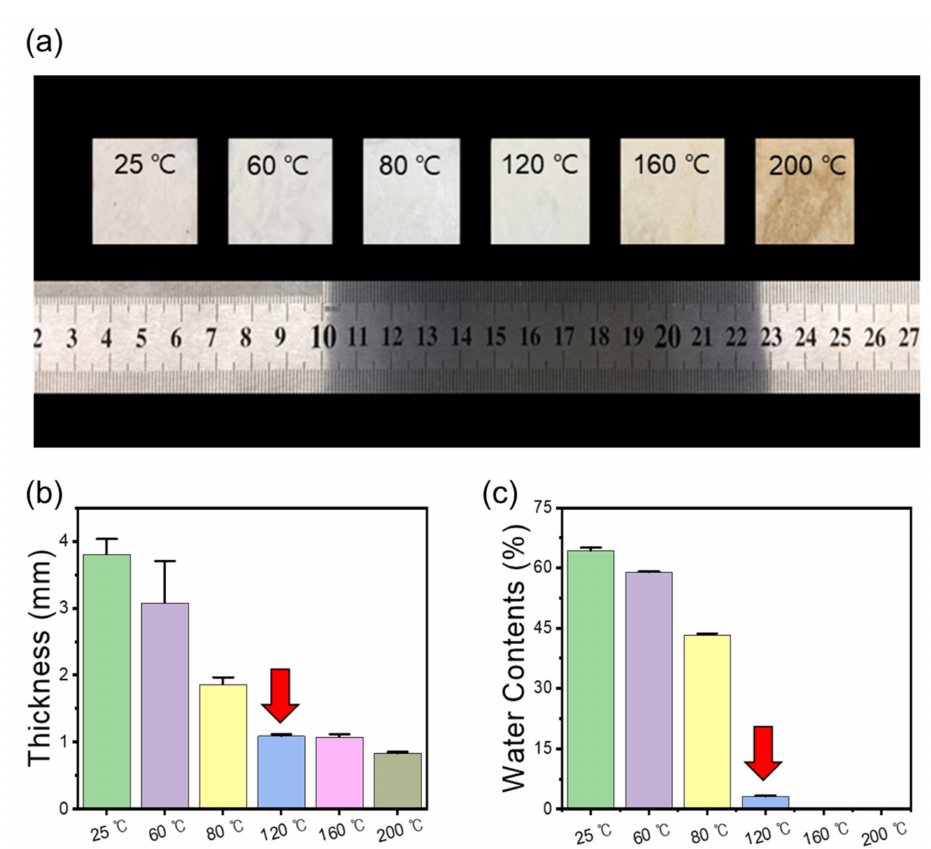
Figure 2. Effect of thermocompressing temperature on the physical properties of BF/CNF fibrous preforms. ( a ) Optical images, ( b ) thickness, and ( c ) water contents of BF/CNF fibrous